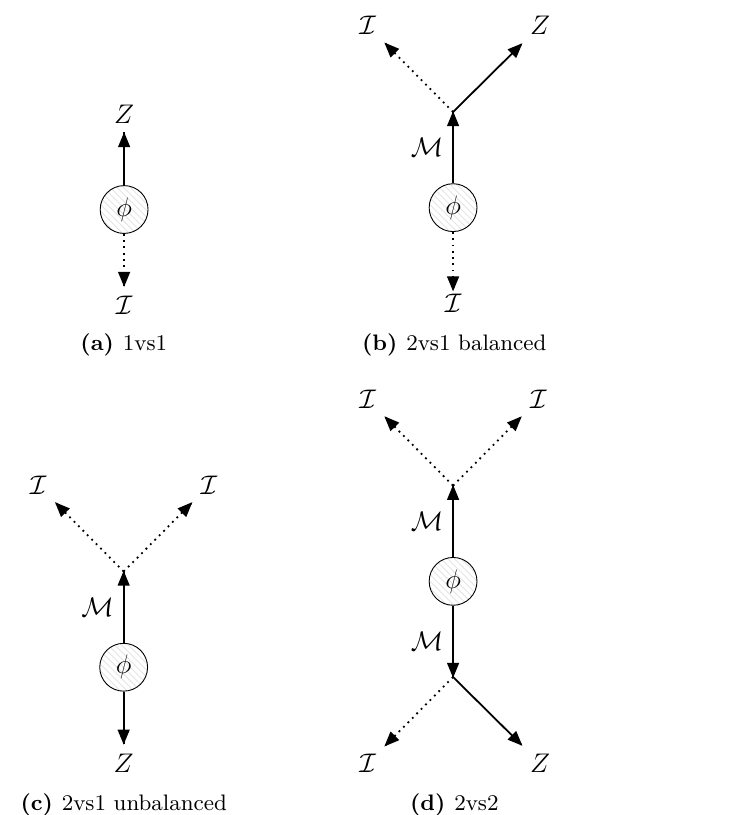
Figure 1. Decay topologies of a neutral scalar boson φ decaying in its rest frame to a Z boson plus E miss . T